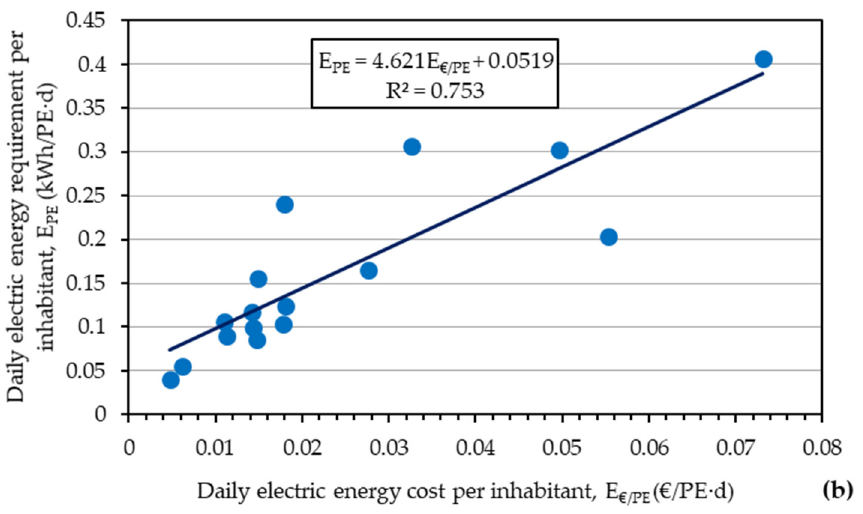
Figure 9. Linear correlation between ( a ) the electric energy consumption per m 3 (E Q ) and electricity cost per m 3 (E €/V ) and ( b ) the daily energy requirement per inhabitant (E PE ) and the daily electrical cost per inhabitant (E €/PE ).